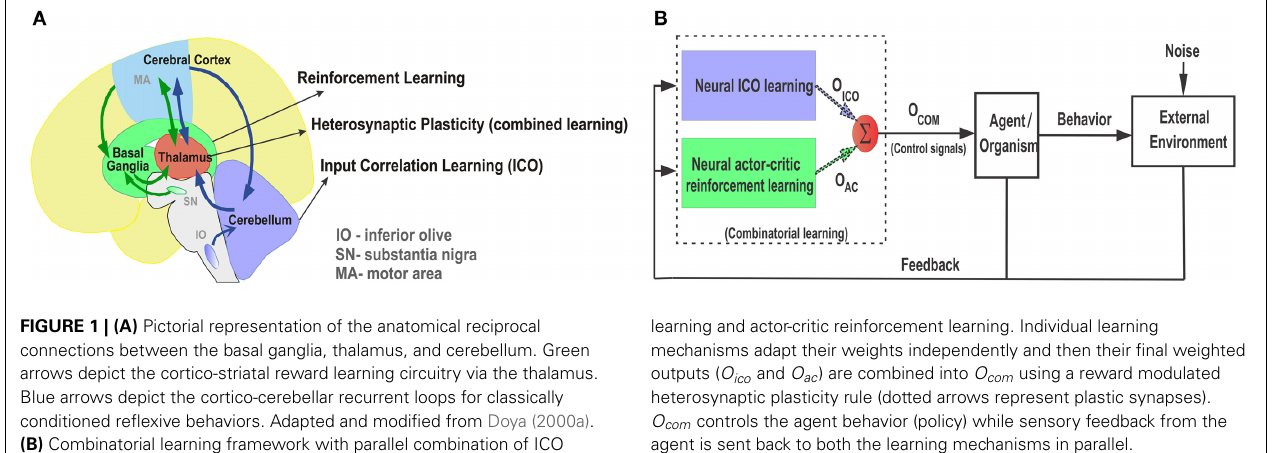
FIGURE 1 | (A) Pictorial representation of the anatomical reciprocal connections between the basal ganglia, thalamus, and cerebellum. Green arrows depict the cortico-striatal reward learning circuitry via the thalamus. Blue arrows depict the cortico-cerebellar recurrent loops for classically conditioned reflexive behaviors. Adapted and modified from Doya (2000a). (B) Combinatorial learning framework with parallel combination of ICO